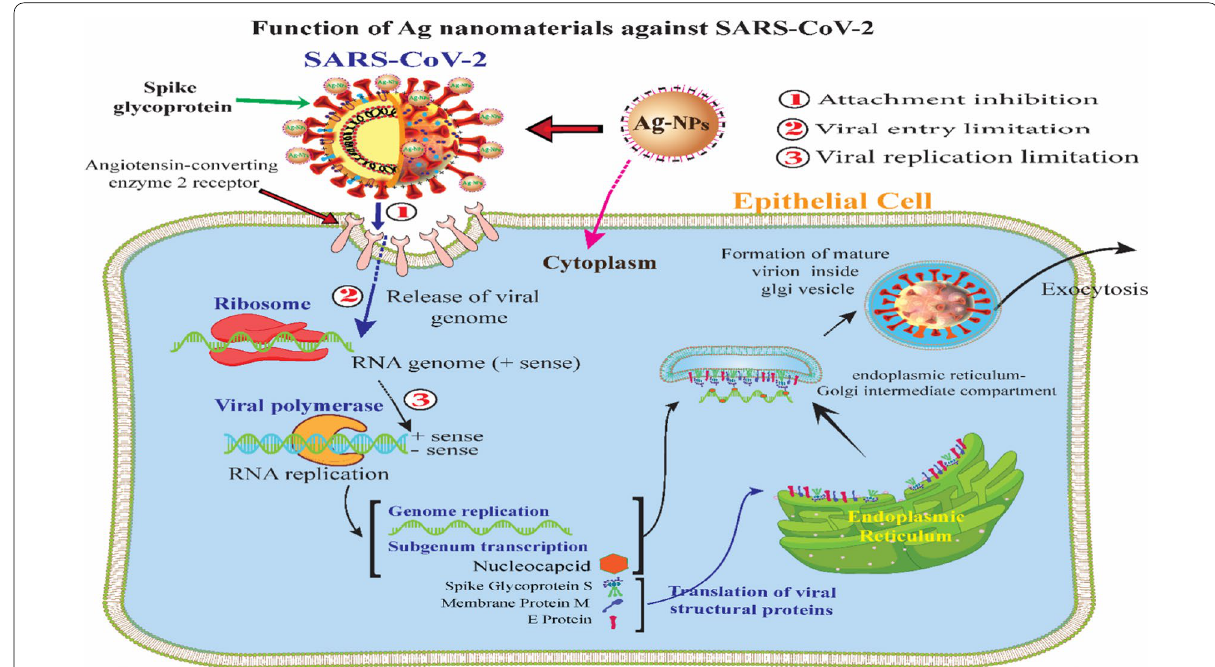
Fig. 2 The conceptual design of the function of Ag NMs for antiviral